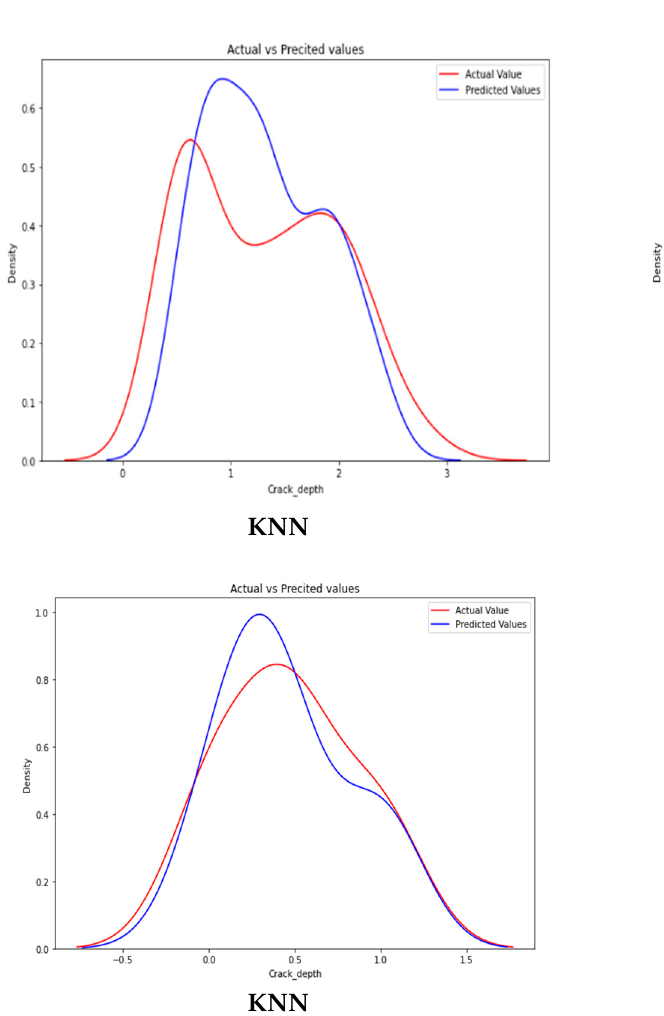
Figure 11. The model prediction values plotted against the actual crack depth measurements for ABS and aluminum.